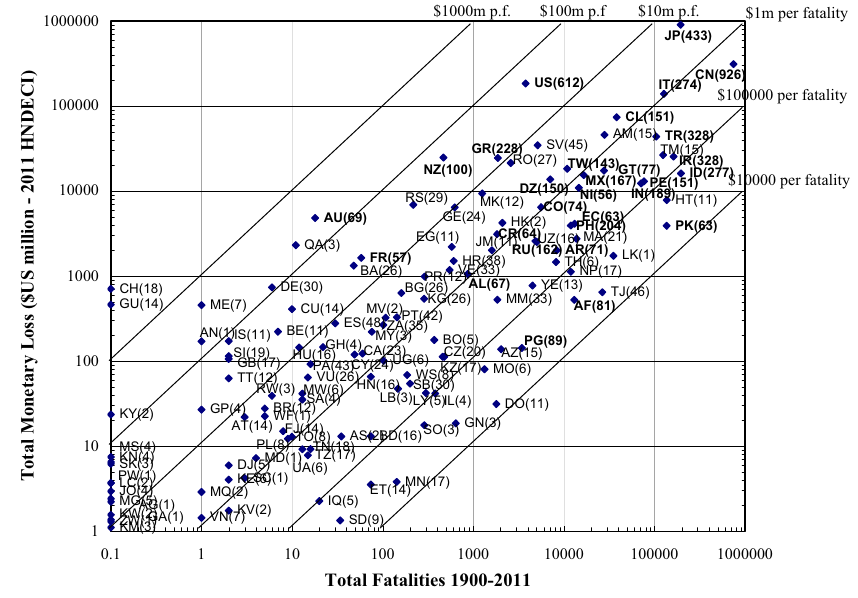
Fig. 16. The cumulative average economic losses (2011 HNDECI Million Dollars) vs. fatalities for each country (ISO code) with the number of damaging earthquakes from 1900–2011.